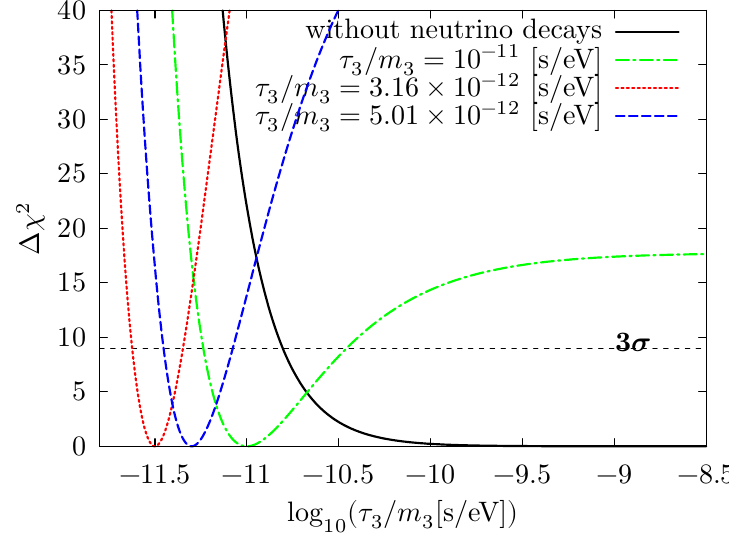
Figure 5 . The (cid:1) (cid:31) 2 = (cid:31) 2 (cid:0) (cid:31) 2 as a function of the test value of (cid:28) 3 =m 3 where the input (true) min value of (cid:28) 3 =m 3 is assumed to be 1 (black solid), 10 (cid:0) 11 (green dashed-dotted), 5 : 01 (cid:2) 10 (cid:0) 12 (blue short-dashed) and 3 : 16 (cid:2) 10 (cid:0) 12 s = eV (red dotted) for MOMENT. We see that as the true value of (cid:28) 3 =m 3 gets smaller, the constraint becomes tighter, especially the upper bound.